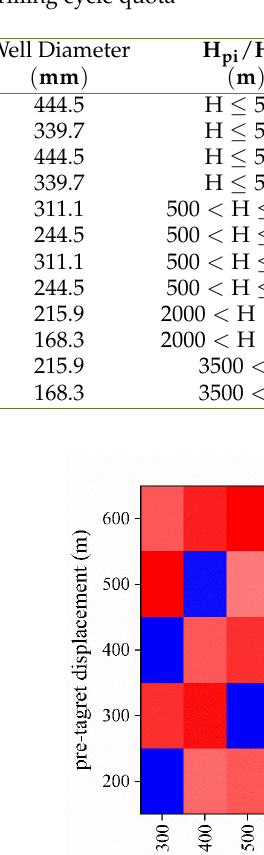
Table 1. Drilling cycle quota